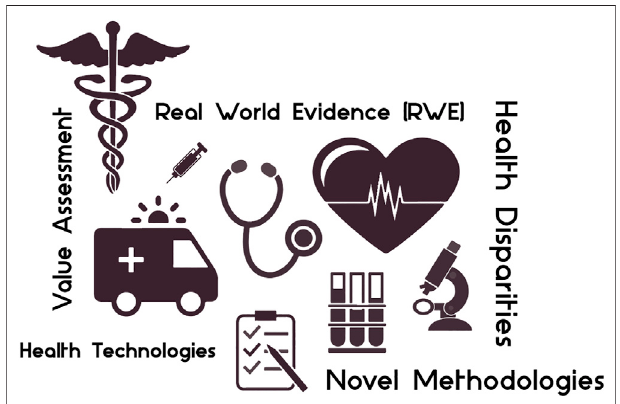
FIGURE 1 | Drivers of healthcare decision-making